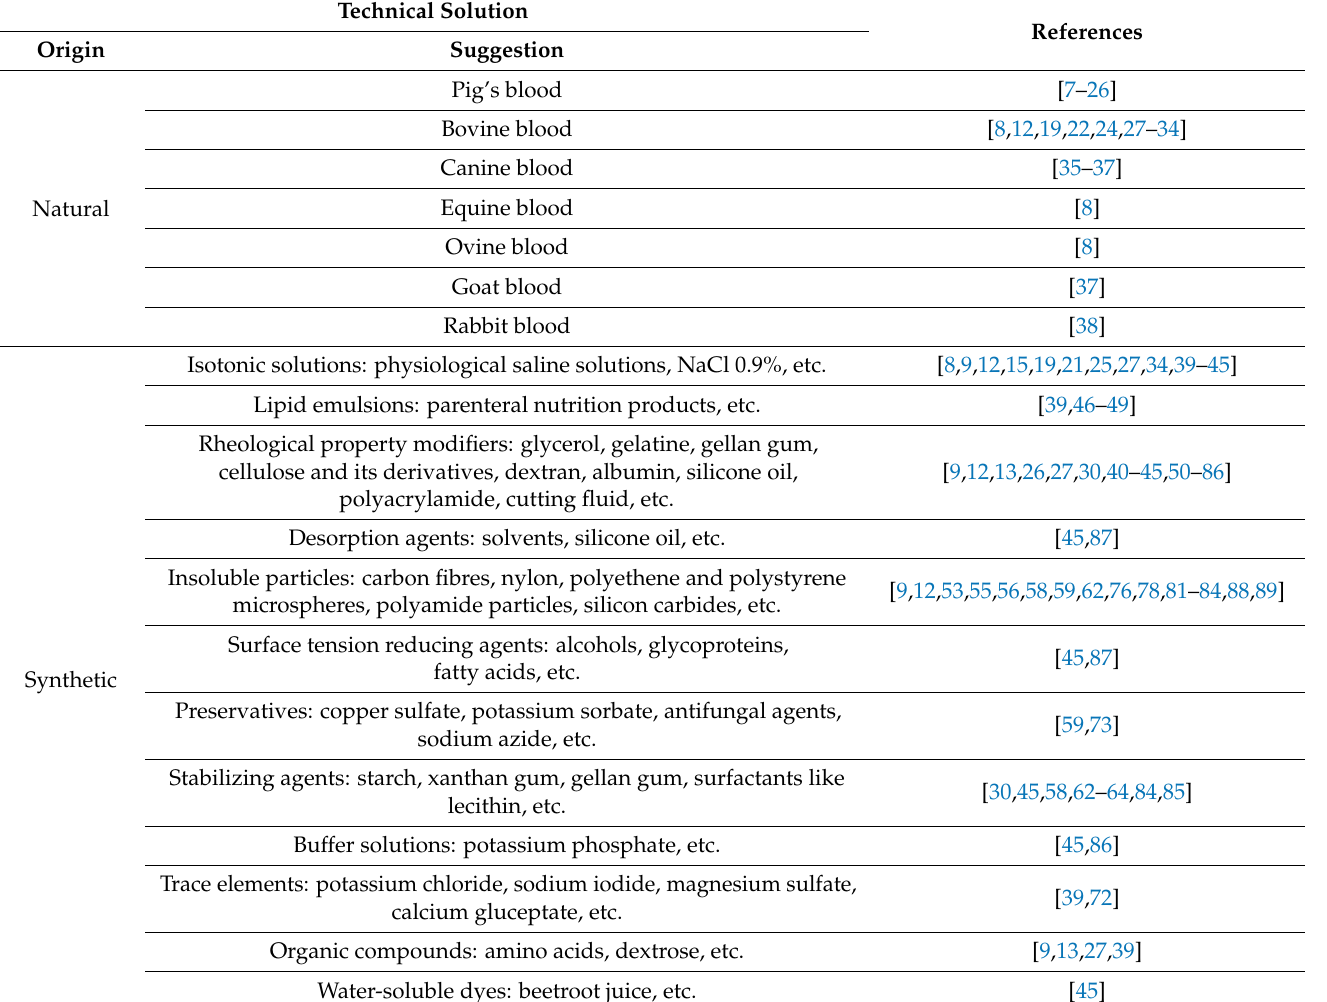
Table 6. Classification of technical